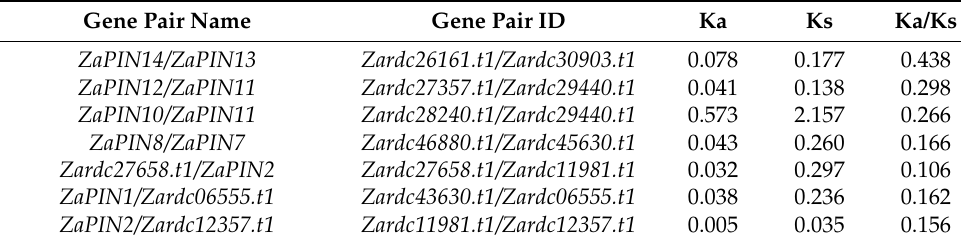
Table 4. Ka/Ks analysis of collinear gene pairs of Z. armatum .